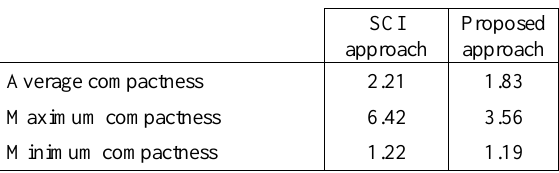
Table 3. Comparison of compactness